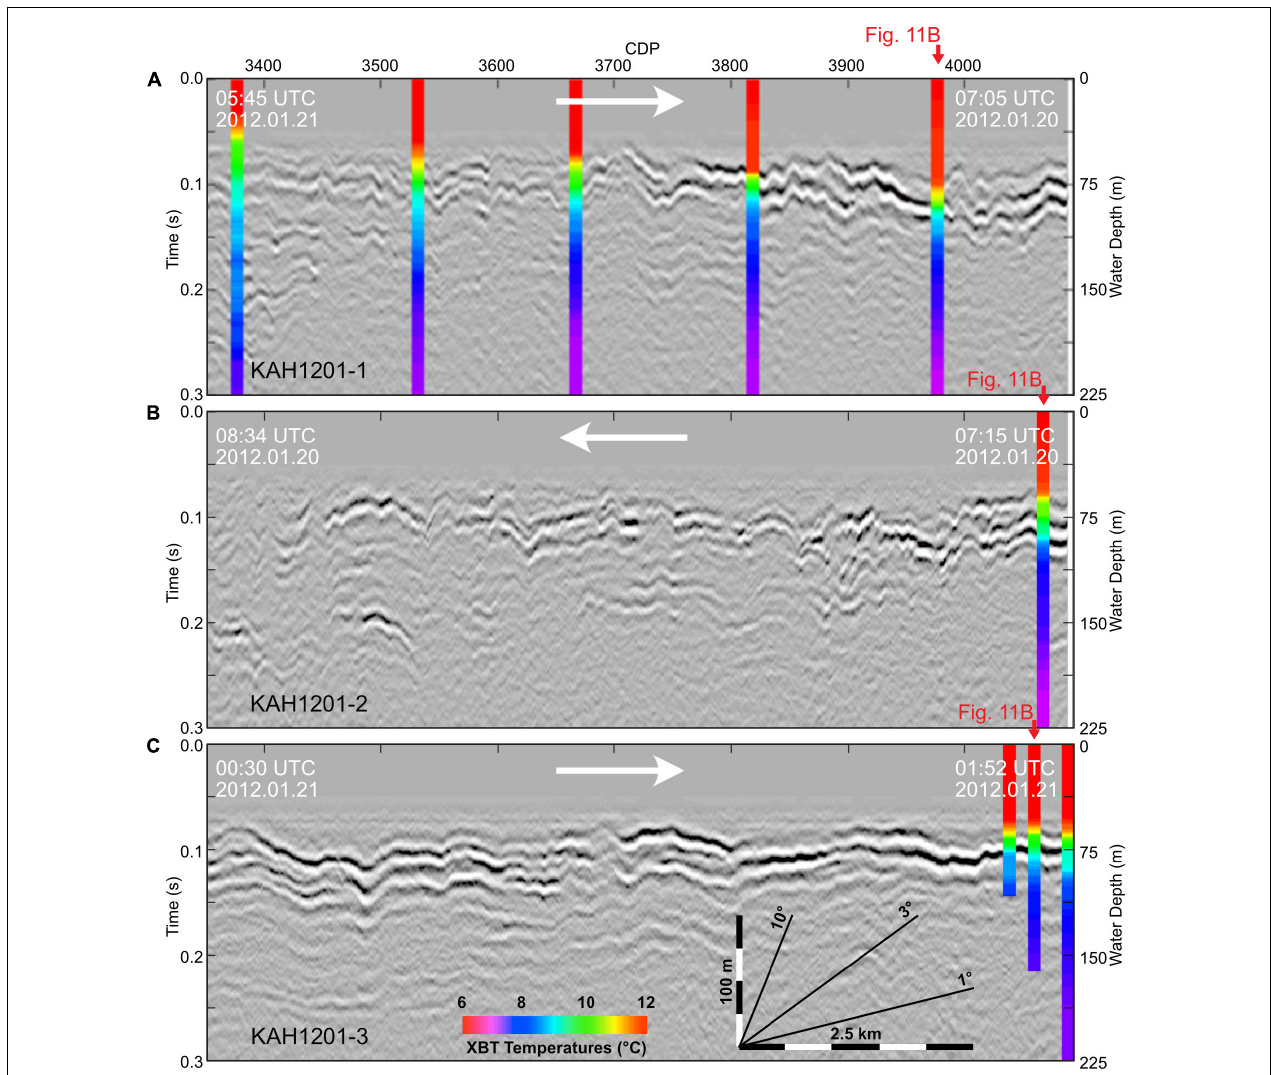
FIGURE 10 | Portions of lines KAH1201-1 (A) , KAH1201-2 (B) , and KAH1201-3 (C) acquired in the same location (as indicated in Figure 2 ), with acquisition times and directions indicated by white arrows. XBT temperatures are overlain in color. Red arrows indicate the location of XBTs shown in Figure 11